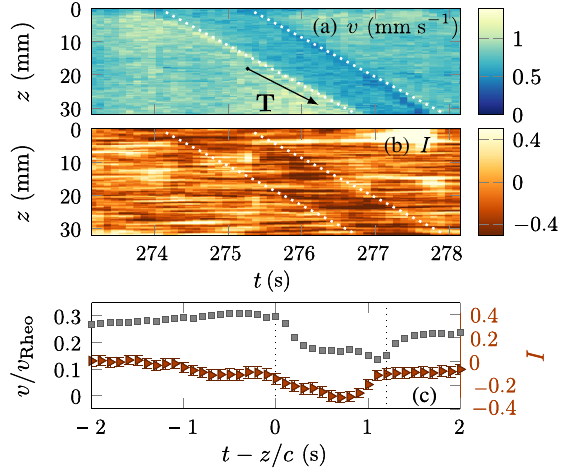
FIG. 6. Signature of a propagating event in regime II for σ ¼ 80 Pa. Spatiotemporal maps of (a) the local velocity v ð r; z; t Þ and (b) the ultrasonic intensity I ð r; z; t Þ averaged in the r direction. (c) Normalized velocity v=v intensity I (orange) averaged over isophases t − z=c ¼ const along the direction T of band propagation with c ¼ 12 . 2 mm s − 1